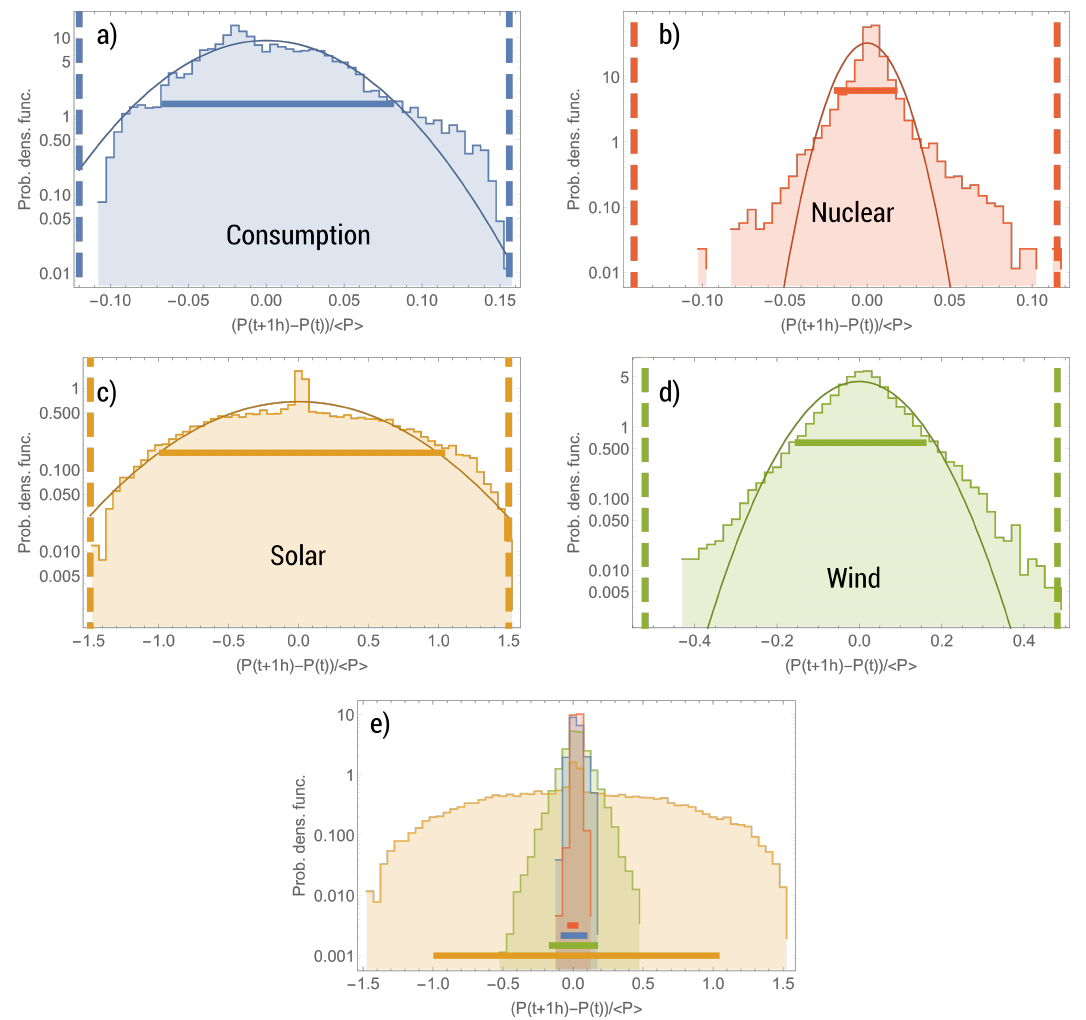
Figure 1. Histogram of the relative variations of the instantaneous power over 1 h: P ( t + 1 h ) − P ( t ) / (cid:104) P (cid:105) . ( a ) consumption (blue); ( b ) nuclear (red); ( c ) solar photovoltaic (PV) (yellow); ( d ) wind (green). Solid lines show a Gaussian distribution with the same standard deviation for comparison. Dashed vertical lines indicate the minimum and maximum values. The horizontal bar marks the interval between the 5th and 95th percentiles, where 90% of the events occur, which will be used to quantify the spread of the distribution in the next section. The last figure ( e ) shows the same data with the same sampling for all four sectors in order to ease the